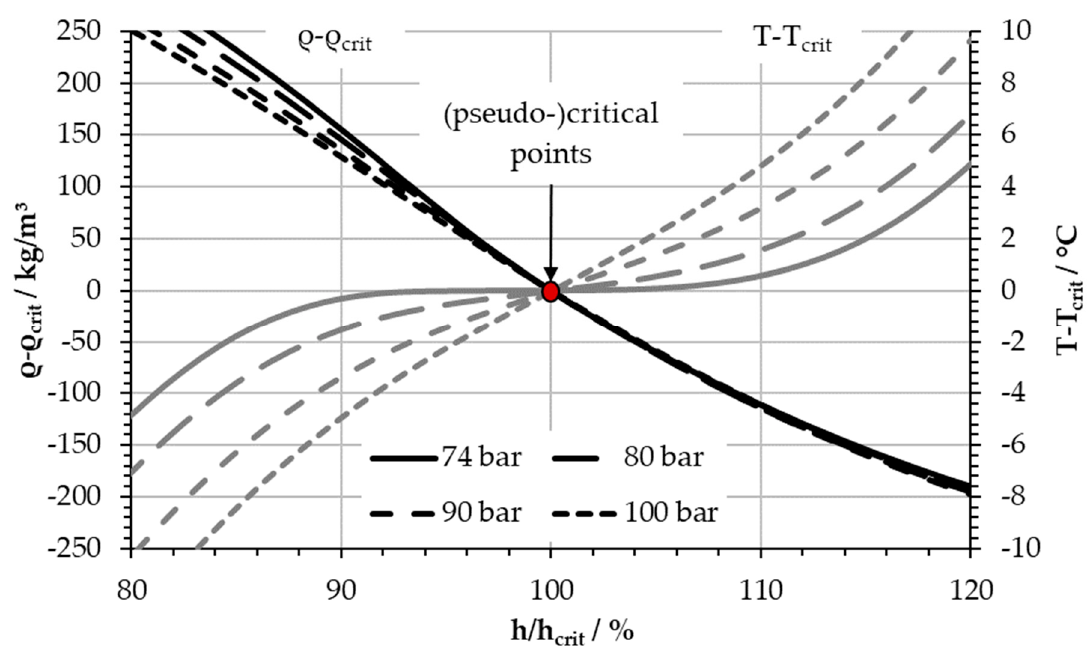
Figure 8. Density and temperature as function of the enthalpy related to the values at the (pseudo)critical point for different pressure levels.